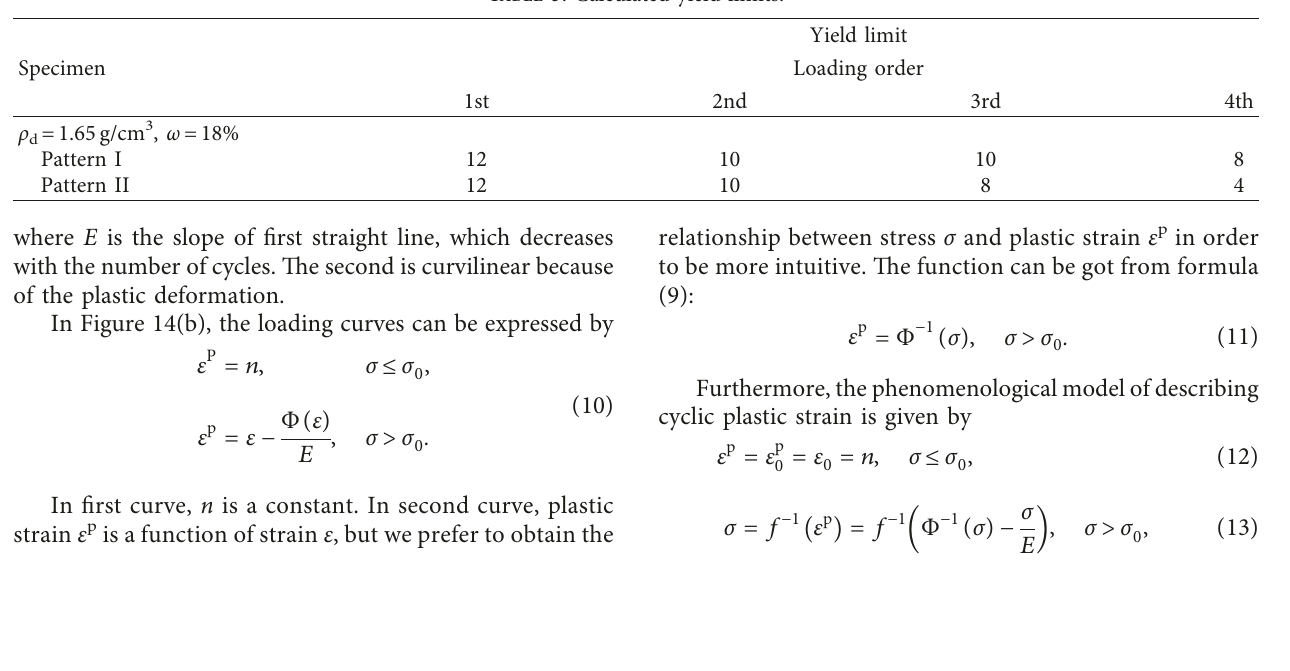
Figure 15: Stress-strain curves of the cyclic tests for (a) loading pattern I and (b) loading pattern Table 5: Calculated yield limits.